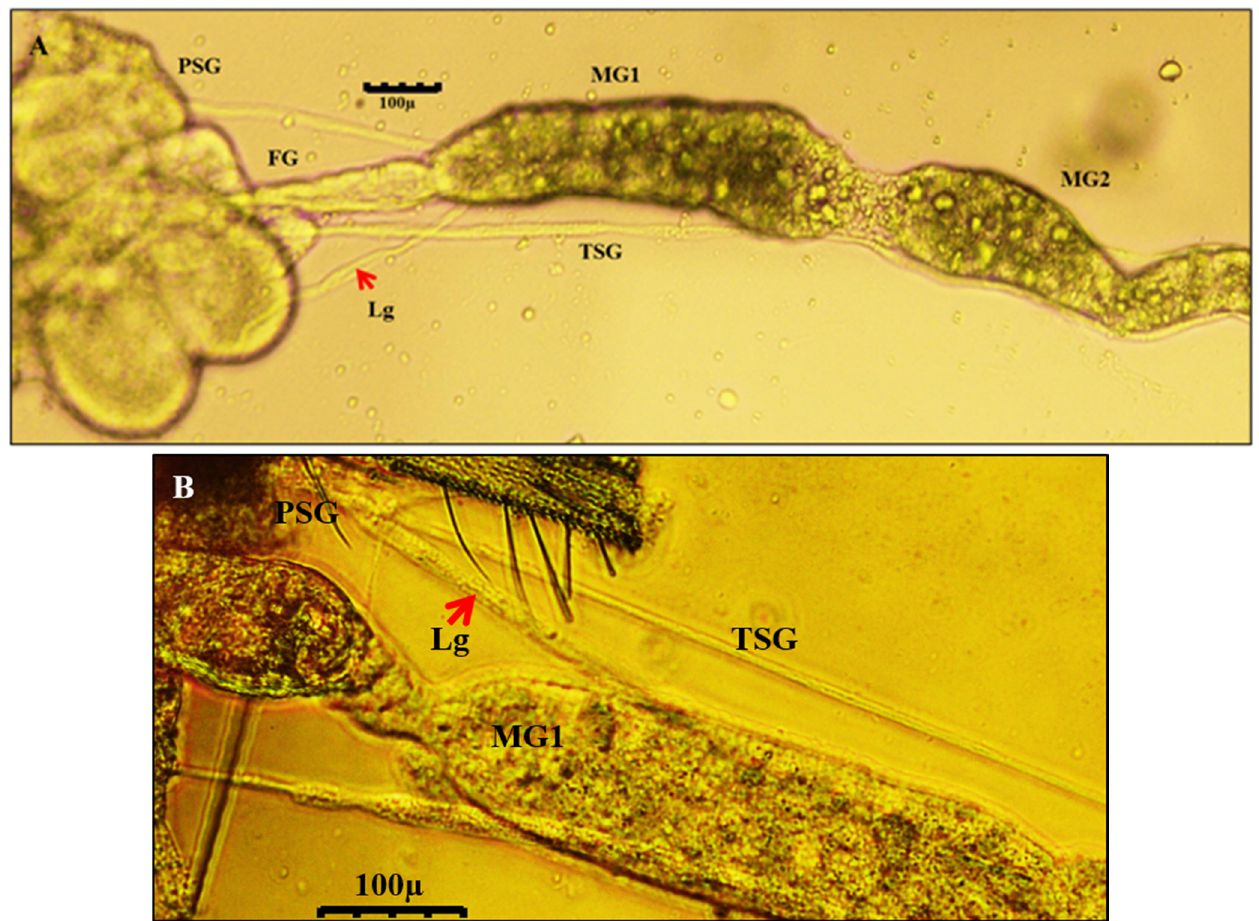
Figure 2. Salivary glands and alimentary tract of Thrips palmi viewed by light microscopy. ( A ) Larval stage ( B ) Adult stage. Figure 1. midgut 1; MG2—midgut 2; PSG—principal salivary gland; TSG—tubular salivary gland. TSG meets the midgut at the junction of MG1 and MG2. A pair of ligaments (Lg; red arrow) connects PSG with the anterior part of MG1. The connection of PSG with midgut via ligaments and TSG remains intact across the life stages.